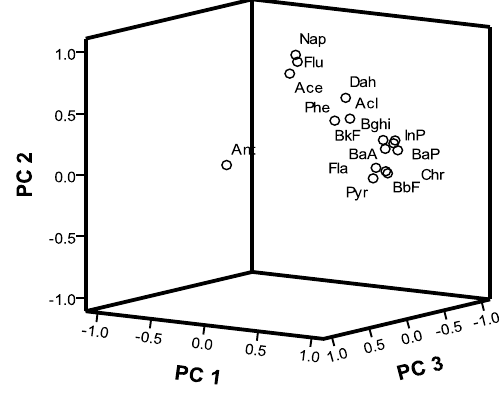
Figure 8. The Principal component loading plot of 16 PAHs.